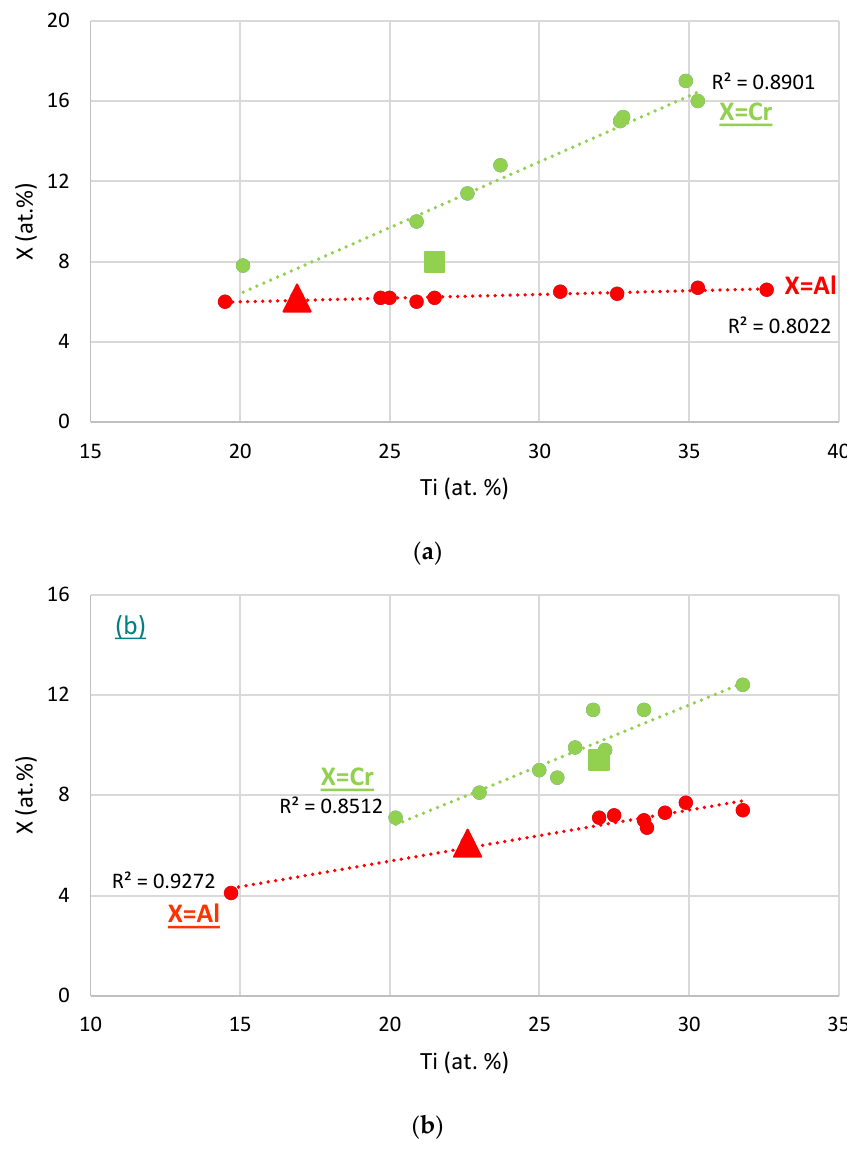
Figure 9. Data for solute element X=Al or Cr in Nb ss ( a ) in cast and ( b ) heat treated KZ series alloys (data is shown by filled circles), and in the NbSiTiHf-5Al and NbSiTiHf-5Al-5Cr alloys. The data for X = Al or Cr in Nb ss in NbSiTiHf-5Al-5Cr and NbSiTiHf-5Al is shown by squares and triangles, respectively. Data for X=Al or Cr are shown in red and green, respectively. The alloying elements in KZ series alloys are Al, Cr, Si, Ti, for alloy compositions see [25].